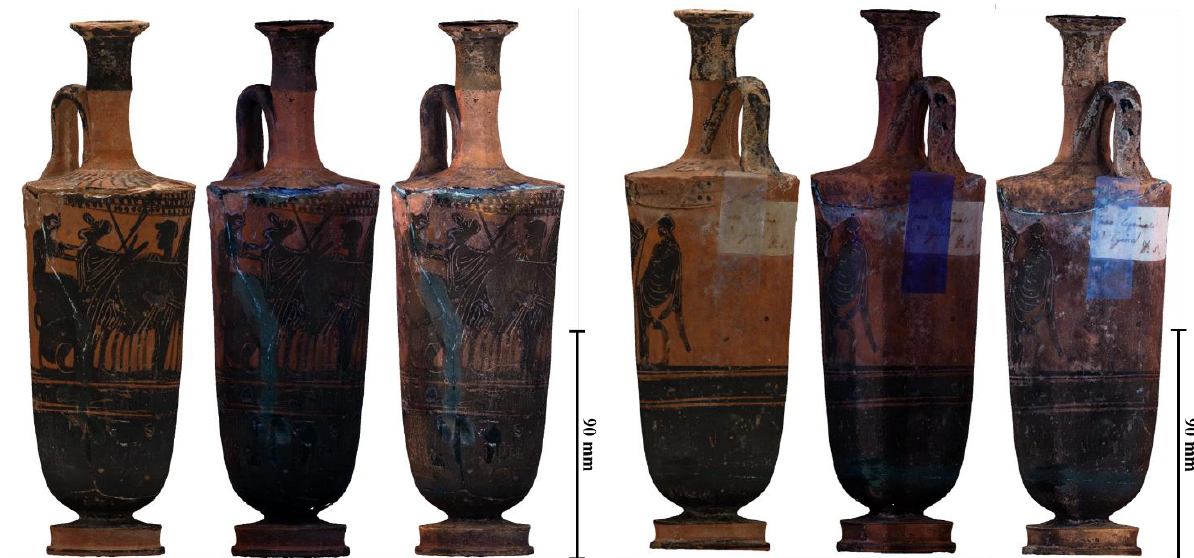
Figure 5. Photogrammetrically derived mesh model with the VIS and UVL texture